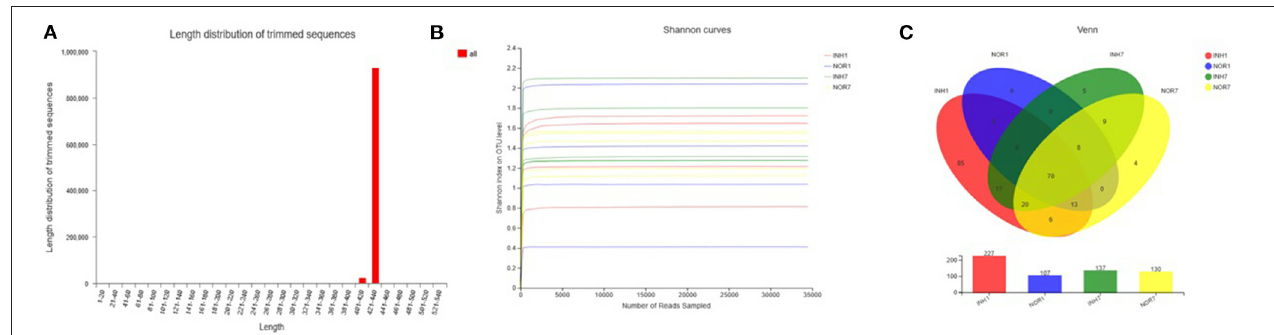
69 orders, 100 families, 152 genera, 183 species, and 198